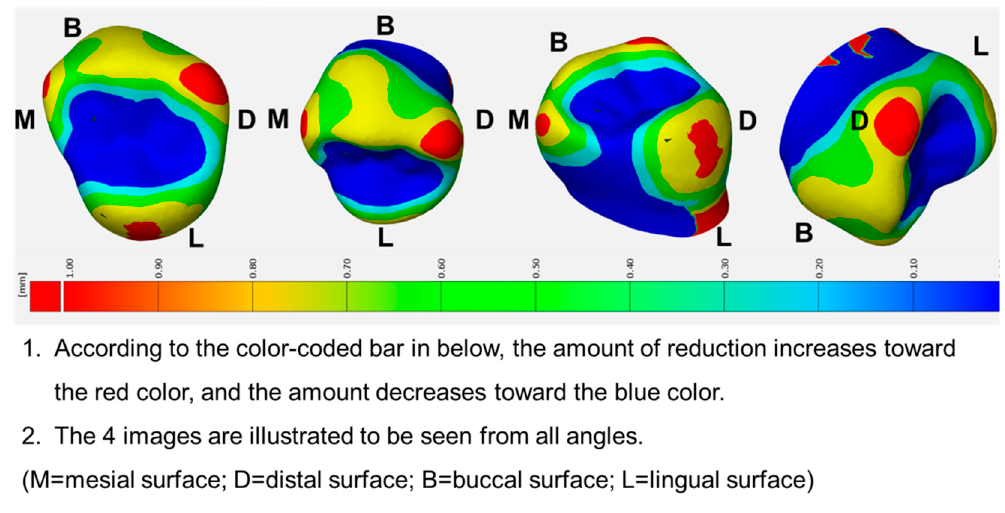
Figure 4. 3D visualization of the tooth preparation guide for left maxillary primary first molar. The required amounts of tooth reduction are provided by a color-coded map. A detailed explanation of the figure was provided to the participants in Korean.